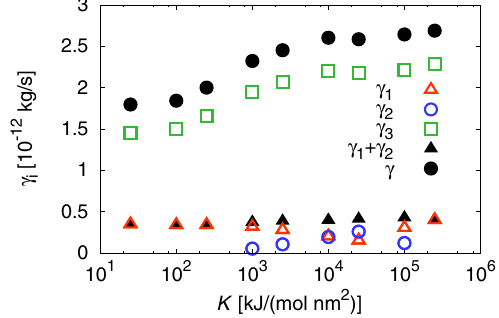
γ defined by Eq. (C1) as a i